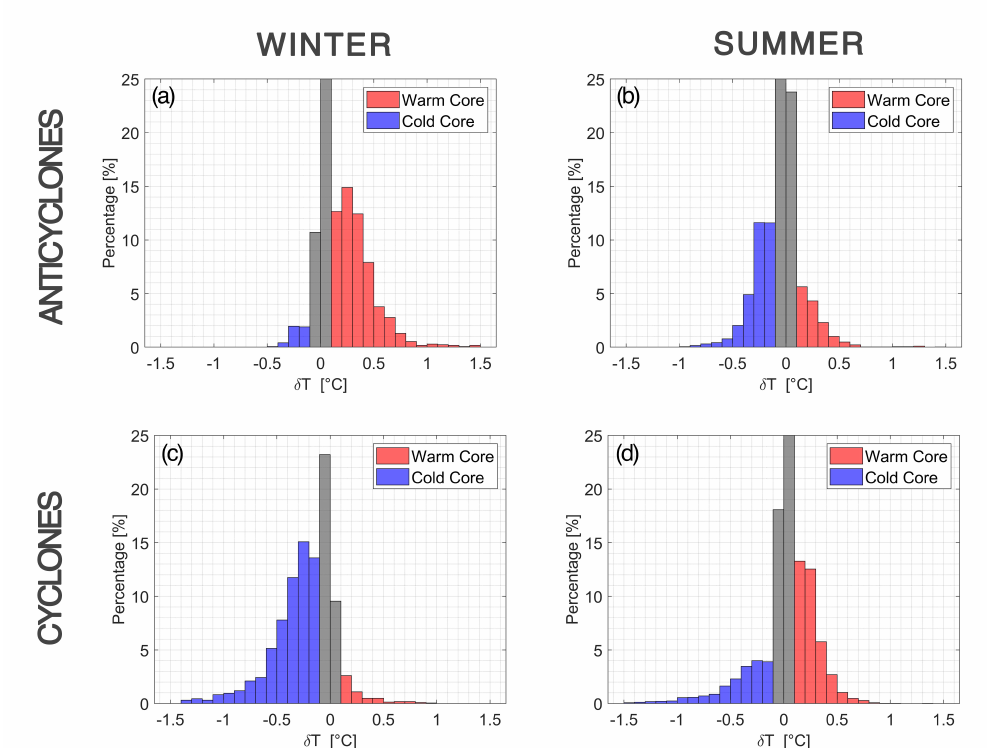
Figure 5. Seasonal histograms of δ T values. ( a ) AE in the winter mixing period (DJF), ( b ) AE in the summer restratification period (MJJ), ( c ) CE in the winter mixing period (DJF) and ( d ) CE in the summer restratification period (MJJ). Red bins represent positive δ T Warm Core observations, while blue bins represent negative δ T Cold Core observations. Grey bins represent observations where | δ T | <